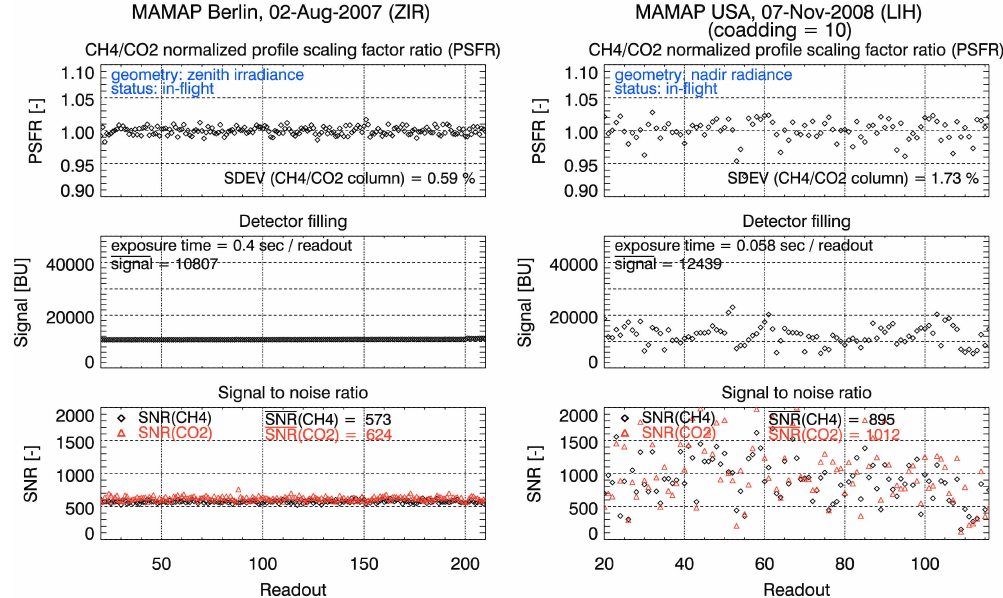
Fig. 11. As Fig. 8 but for in-flight measurements in zenith geometry and for nadir measurements over targets with inhomogeneous reflectance distribution; left: analysis of time series of single detector readout MAMAP CH 4 and CO 2 dynamic “in-flight” zenith sky irradiance measure- ments (solar+hemispheric). Measurements performed over the MAMAP fiber optical inlet equipped with 4 transmissive Spectralon diffuser plates (target ZIR). Measurements conducted on 2 August 2007. Top panel: normalized CO 2 /CH 4 profile scaling factor ratio (PSFR). Sec- ond panel: maximum irradiance (detector filling) in binary units [BU] as measured with MAMAP and digitalized with 16BitADC. Bottom panel: estimated signal-to-noise ratios (SNR) of each measurements; right: as on left side but for co-added burst mode nadir measurements over land targets with inhomogeneous reflectance distribution (target LIH). Co-added measurements derived from measurements shown in Fig. 10 (right) but each burst of 10 measurements co-added and averaged (only measurements with > 3000 [ BU ] are